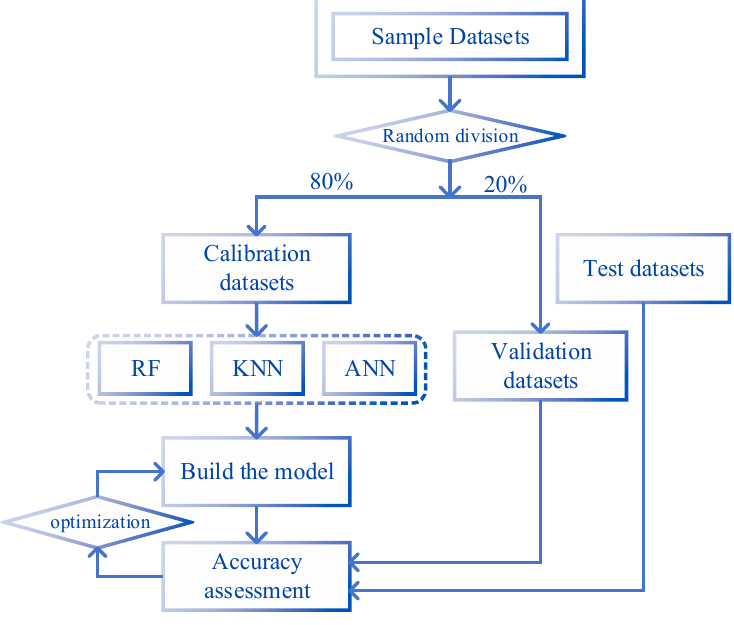
Figure 7. Accuracy assessment scheme.